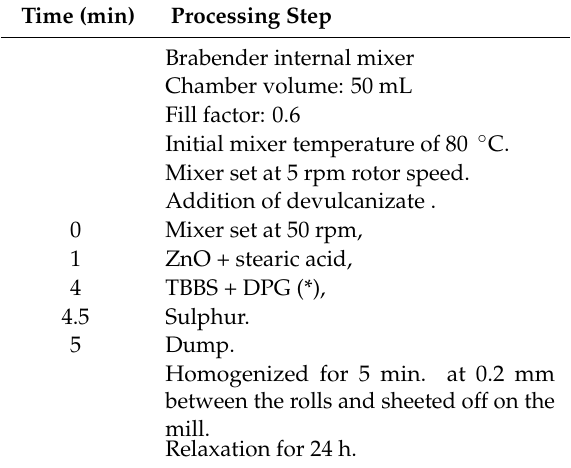
Table 4. Compounding procedure for all re-vulcanizates without silane, without (*) and with